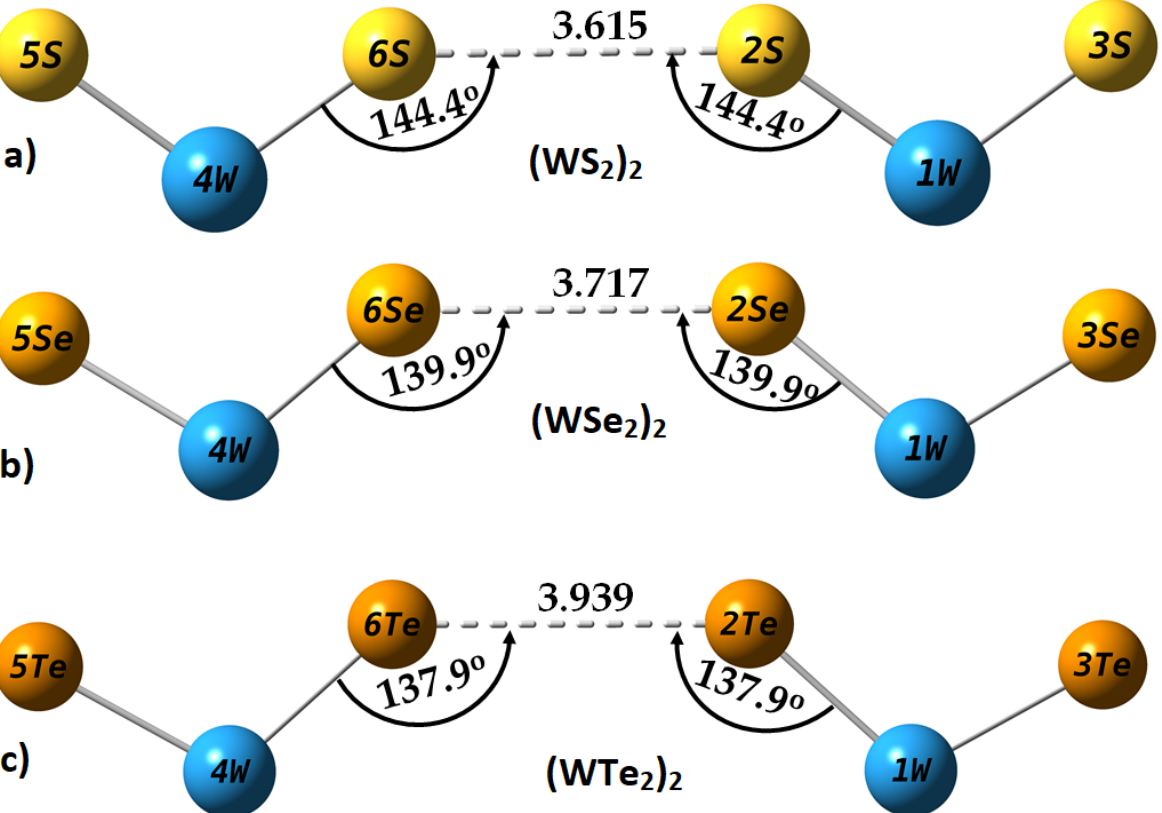
Figure 7. M06-2X/Aug-cc-pVTZ(-PP) computed fully relaxed geometries of (WCh 2 ) 2 (Ch = S, Se, Te) dimers, showing a Type I topology of non-linear Ch ··· Ch bonding links between the interacting monomers: ( a ) (WS 2 ) 2 ; ( b ) (WSe 2 ) 2 ; and ( c ) (WTe 2 ) 2 . Selected bond lengths and bond angles are in Å and degrees, respectively. Atomic numbering and labeling are shown in each case. Table 1. M06-2X computed geometric, electronic, and energetic properties of (WCh 2 ) 2 (Ch = S, Se, Te) dimers, obtained with three different basis sets a,b